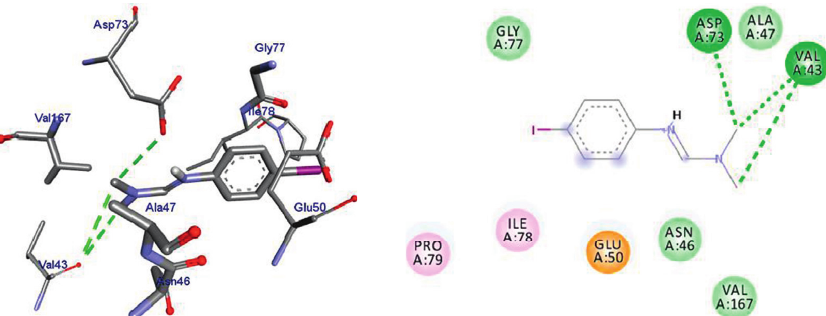
Figure 11: The binding interactions of 21 against E. coli DNA gyrase A (PDB ID: